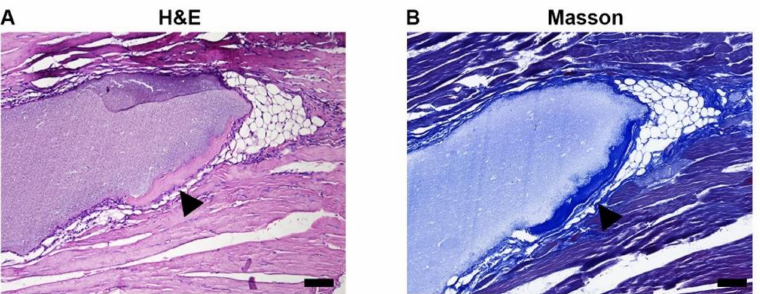
Figure 3. Bone-like formation induced by BCP ceramics. ( A ) HE staining of BCP in muscle after 4-week implantation showed bone-like structure formed around BCP ceramics and even some osteoblasts were found. ( B ) Masson staining of BCP in muscle after 4-week implantation showed bone-like structure formed as indicated by black triangles. Scale bar: 20 µ